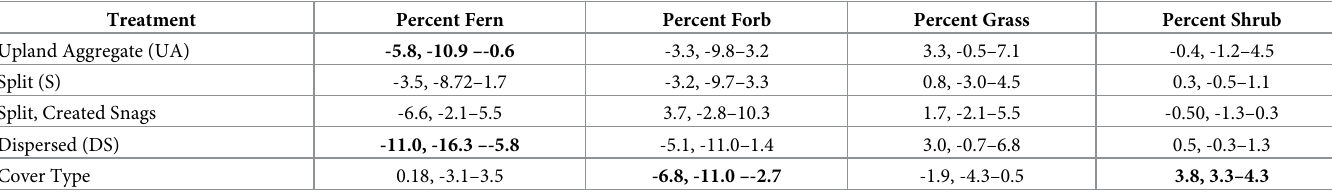
Shrub cover was square root transformed. Reference treatment for all models is Riparian Aggregate (RA). Bold values indicate significant effects with 95% confidence intervals that do not overlap zero.